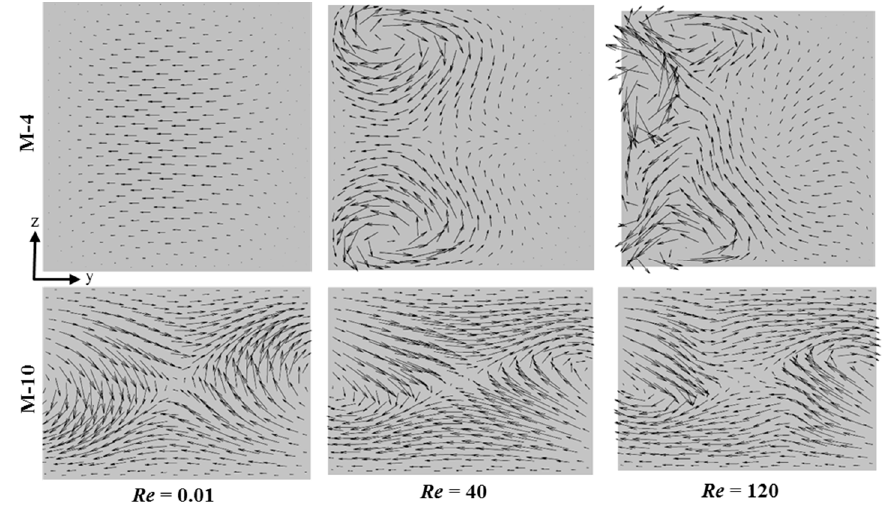
Figure 15. Velocity vectors in M-4 and M-10 at x / L t = 0.16 (plane A2 in Figures 4 and 10) at di ff erent Reynolds numbers.